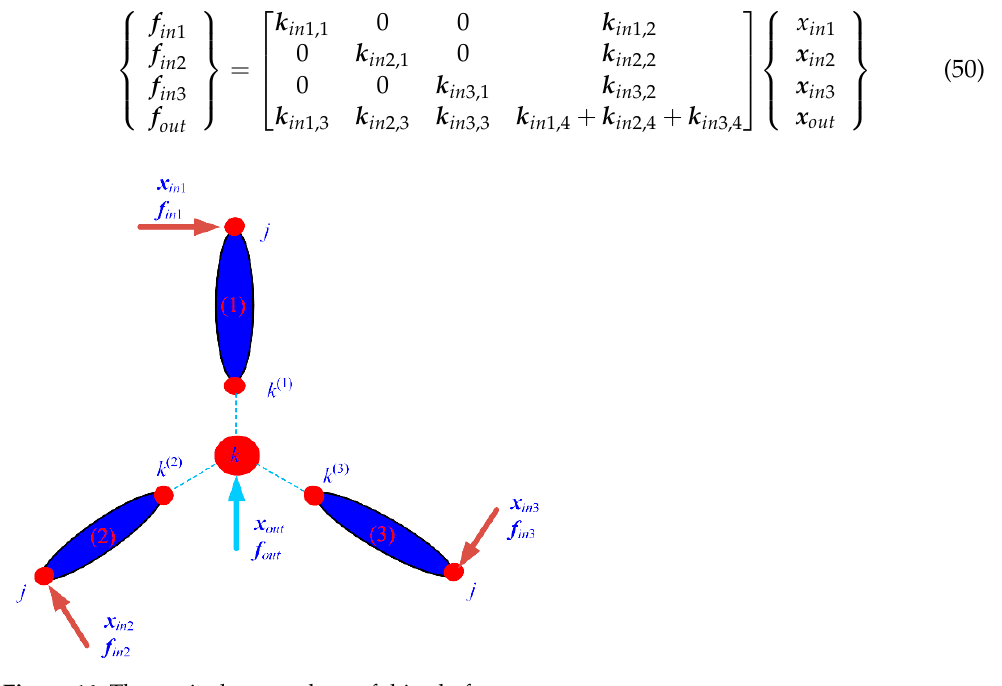
Table 3. The comparative results of the four different methods under the input force of f in 1 = f in 2 = f in3 = 100